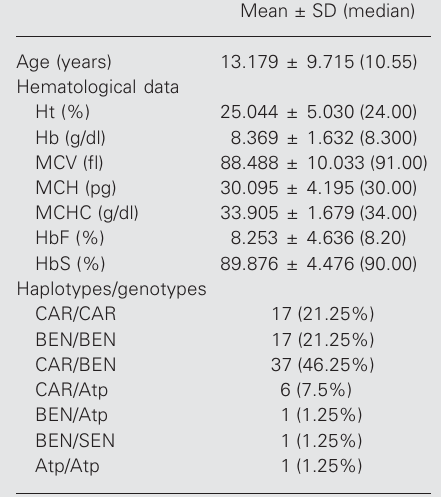
Table 1. Hematological data of the 80 sickle cell disease patients (40 males and 40 females) from Salvador, Bahia, Brazil, and ß S -haplotype frequen- cies and genotype frequencies found among the 80 sickle cell disease